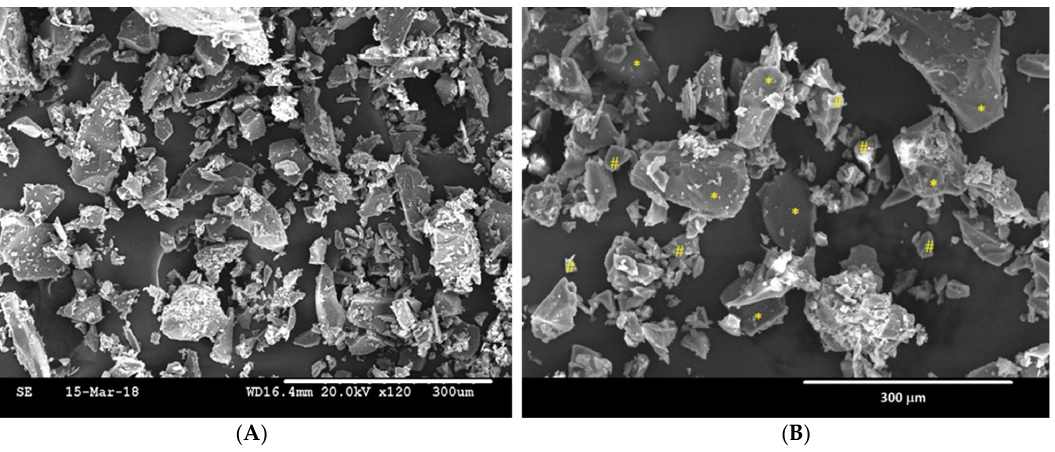
Figure 3. SEM images of the Ge ( A ) and HA-5% Ge powder composite ( B ). (*) HA particles and (#) Ge particles. Scale bar—300 µm Table 1. EDX microanalysis of the HA-Ge composites.